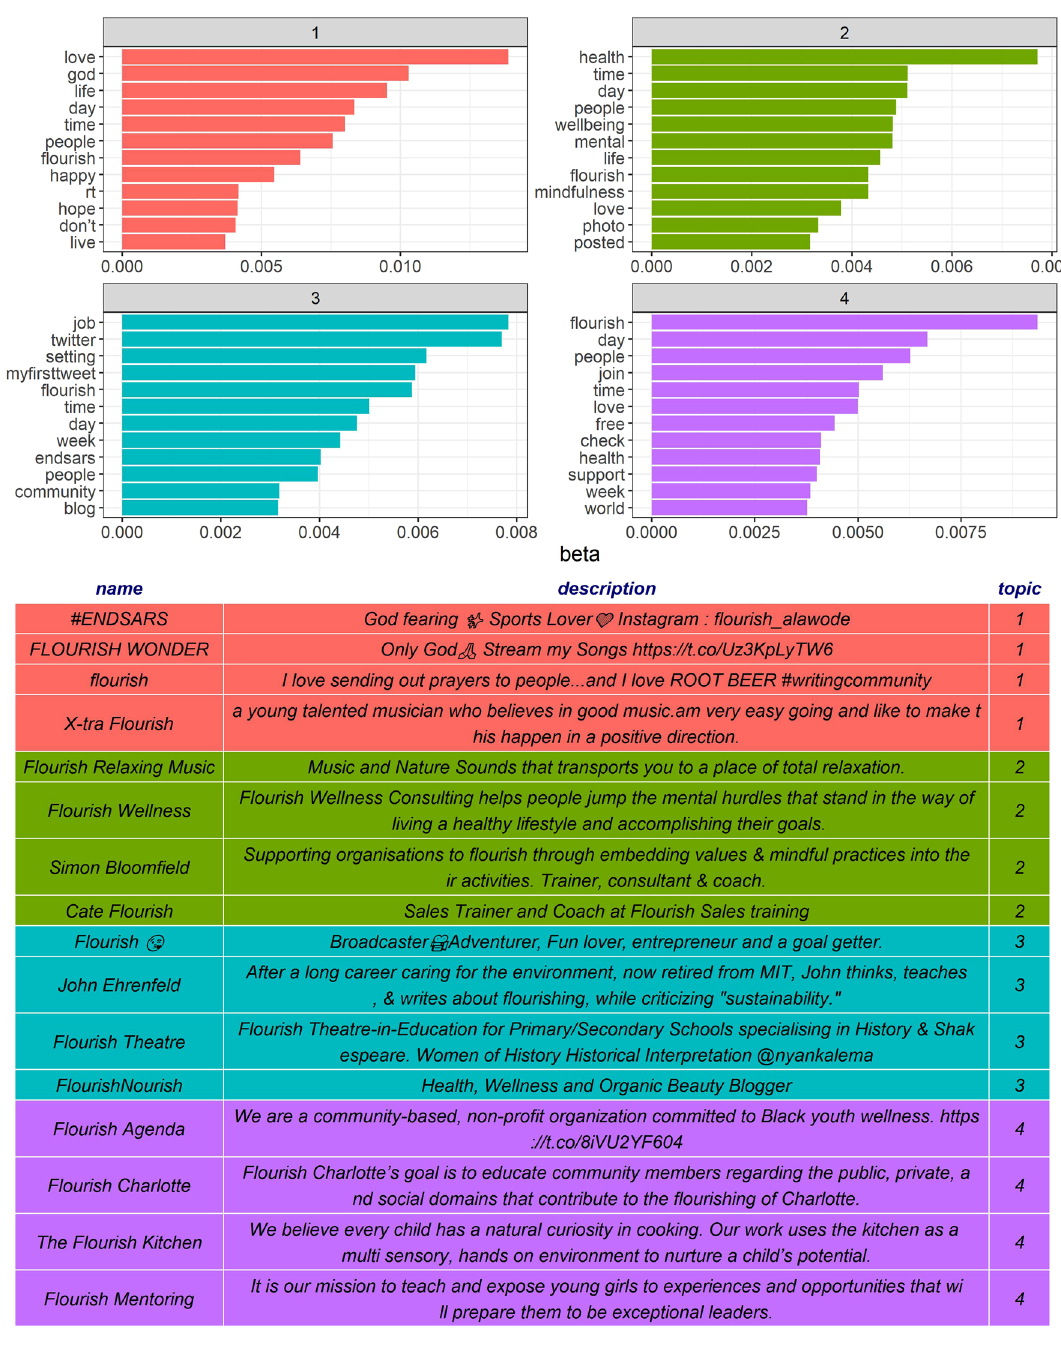
Figure 7. Topic modeling results after applying the LDA algorithm with the k value fixed at 4. The graphs above show the twelve words that relate the most to each topic, while the table below shows the four users—with